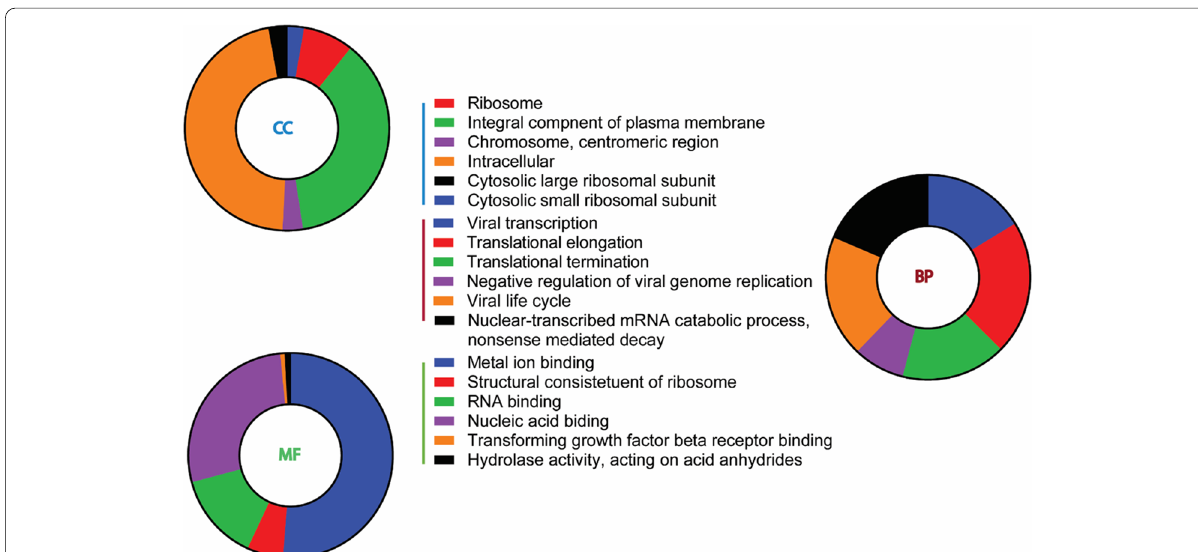
Fig. 6 ORA gene ontology results from innate DB. Each pie chart represents the top six GO terms of the (CC) cellular components, (BP) biological processes, and (MF) molecular functions (padj 0.05) ≤